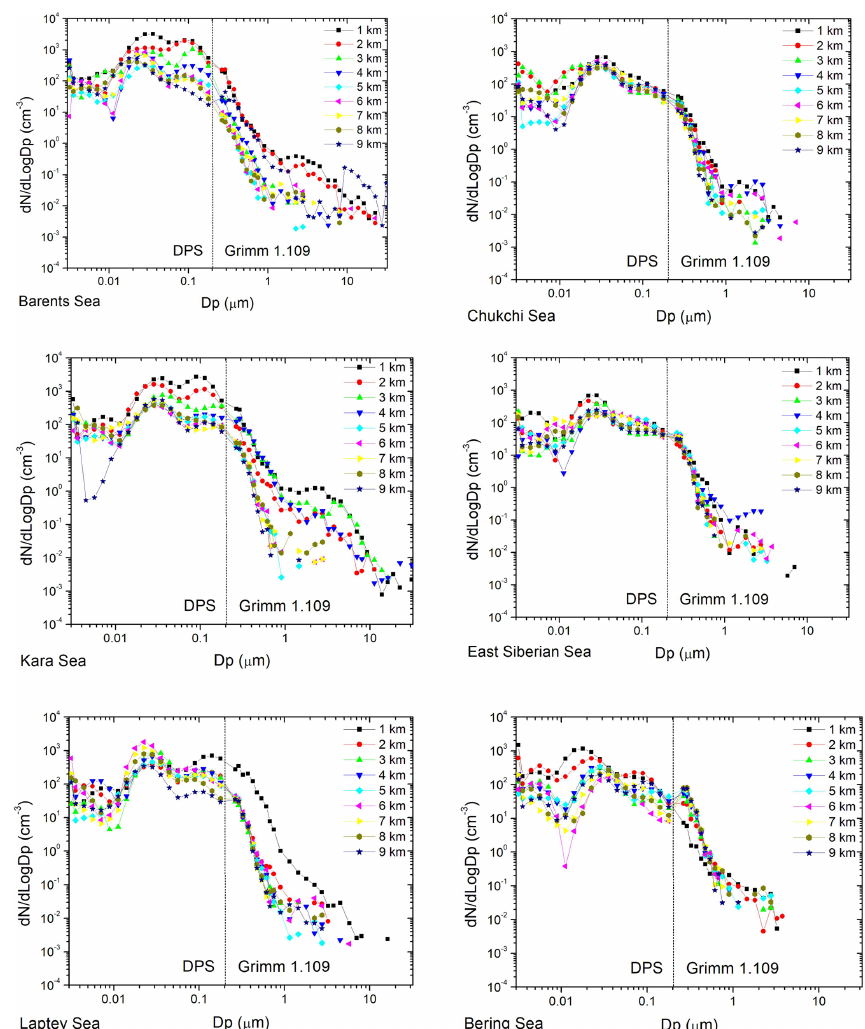
Figure 15. Average particle size distributions observed at different heights over different regions of the Russian Arctic in September